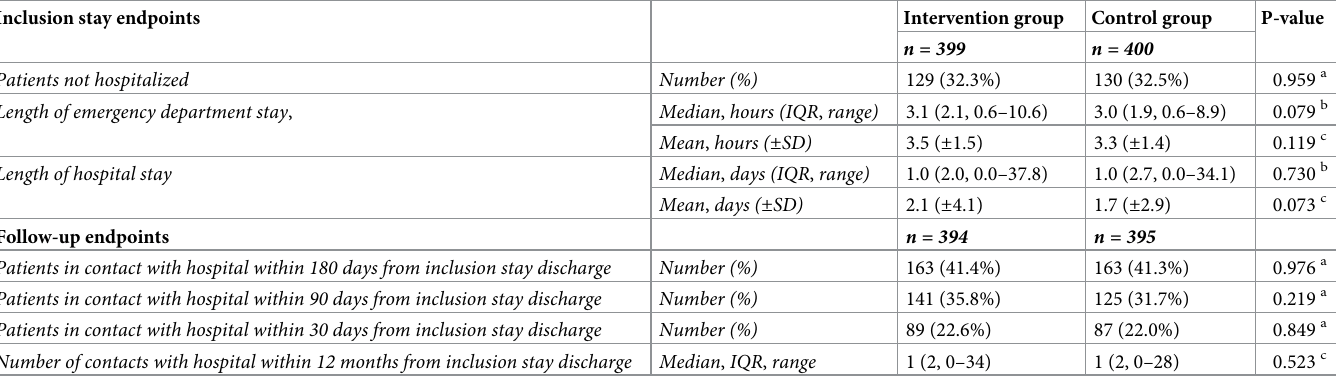
Table 2. Secondary outcomes (Intention-to-treat analysis) comparing intervention- and control group